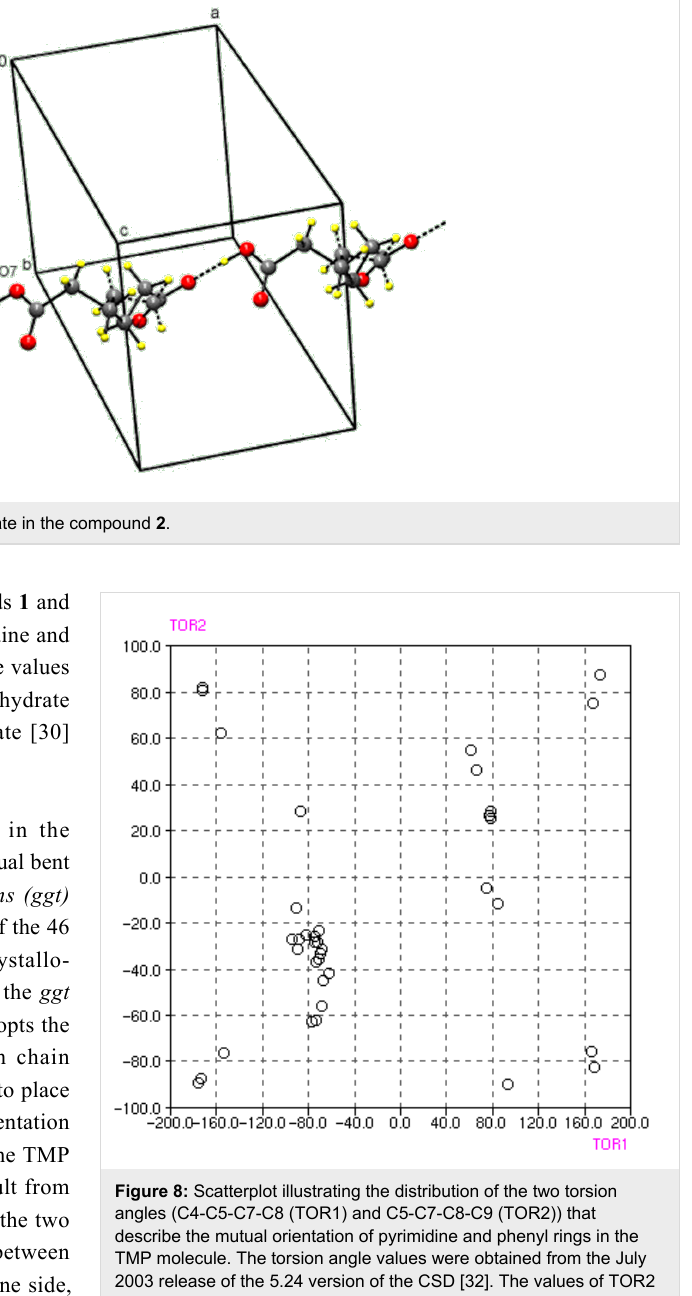
The TMP molecule can be regarded as having a rigid frame,